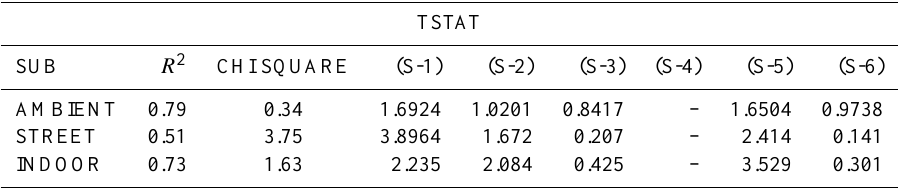
Table 3. Good fit parameters of CMB execution output results for selected receptors.